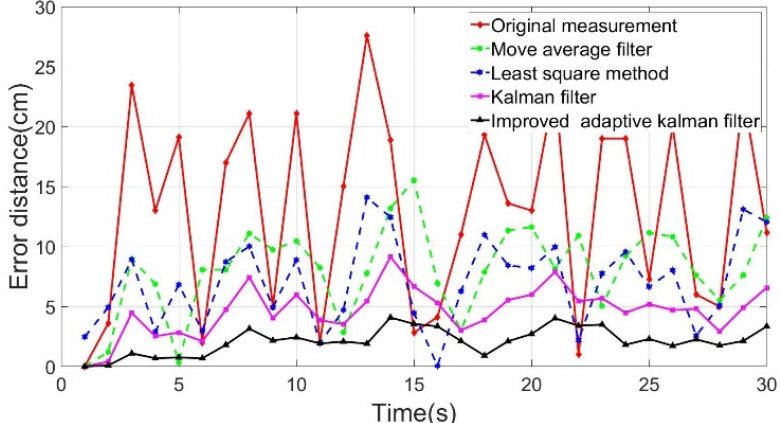
Figure 6. Shifting error distance analysis chart. Table 1. Comparison of average drift error distance and improvement range.